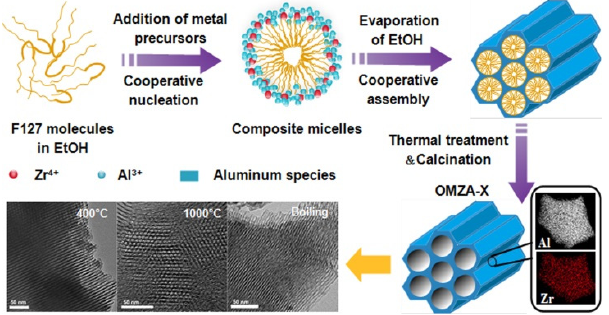
Figure 1. Schematic illustration for the synthesis of ordered mesoporous Zr-Al composite oxide materials (OMZA-x).